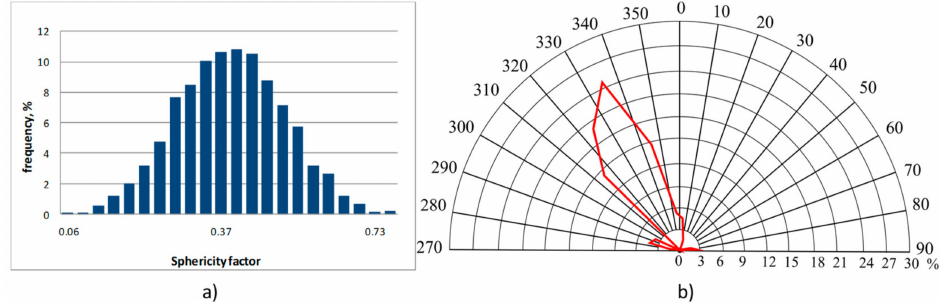
Figure 12. ( a ) Distribution of mica according to the sphericity factor and ( b ) the orientation of the longest